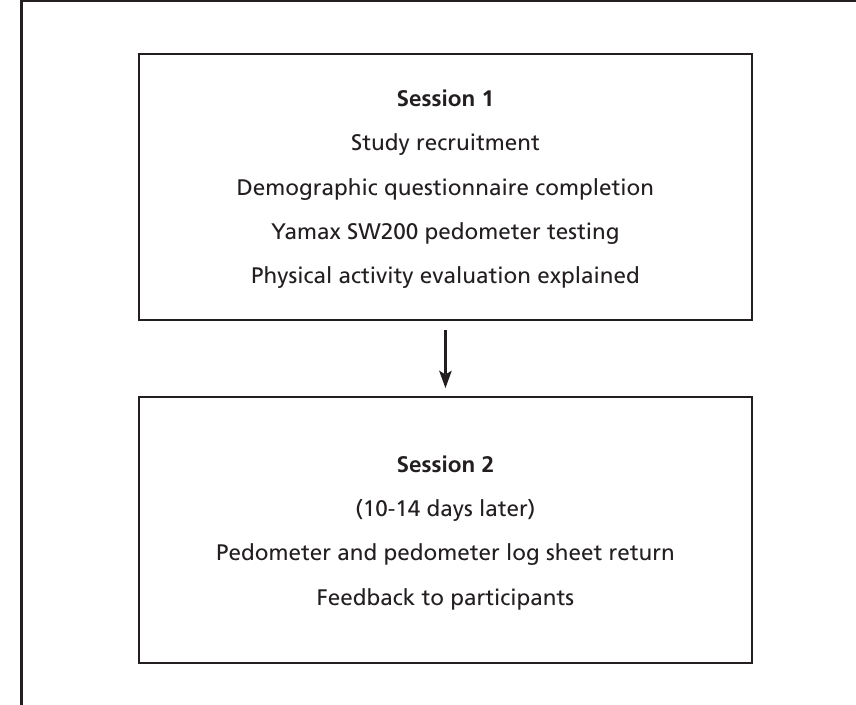
Figure 1: Flow diagram of study Figure 2: Flow diagram to illustrate participants’ retention from interest to